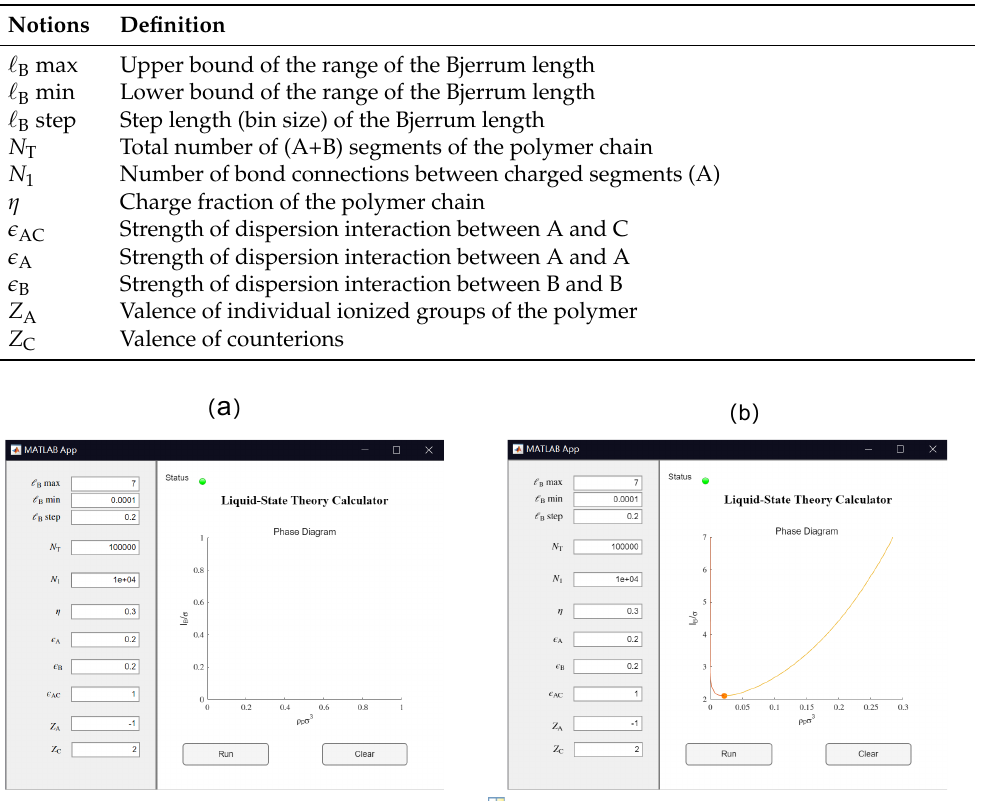
Table 2. Input parameters used in the GUI App. For the salt-free polymer solution, there are three types of beads (see Figure 1): Type A = Charged segments of the polymer; Type B = Neutral segments of the polymer; Type C = Counterions. The strength parameter for the dispersion interaction is introduced in Equation (5).